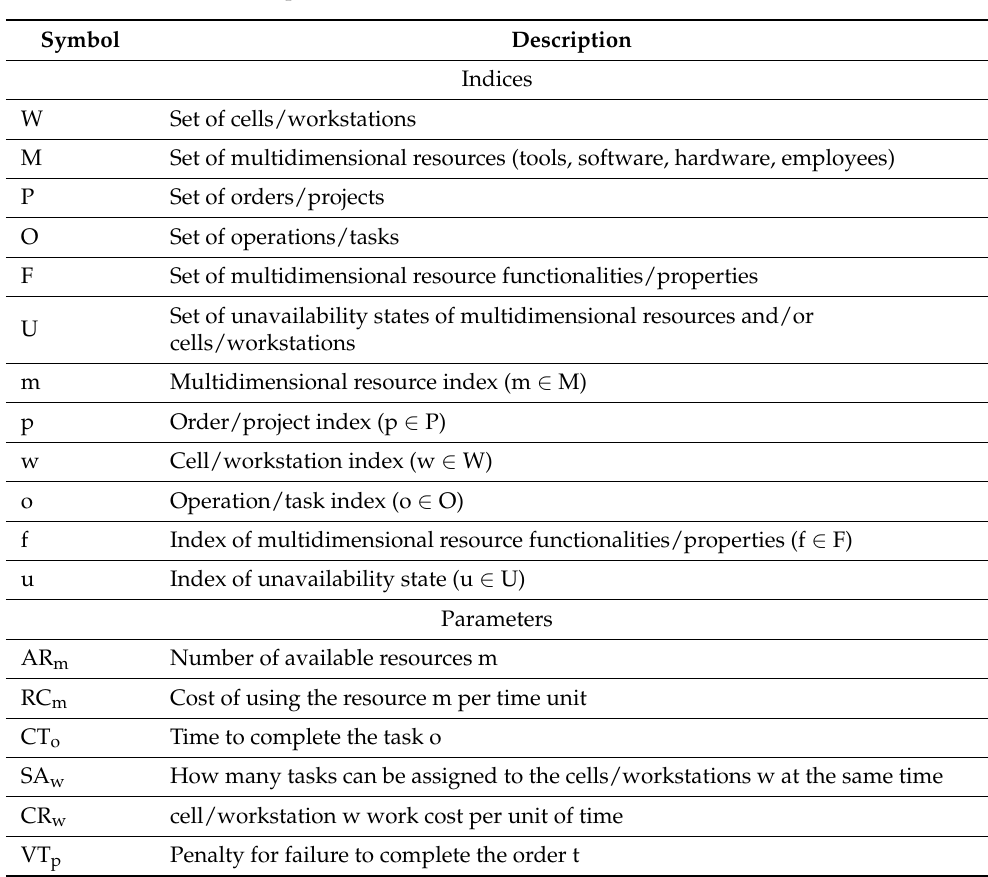
Table 1. Model indexes and